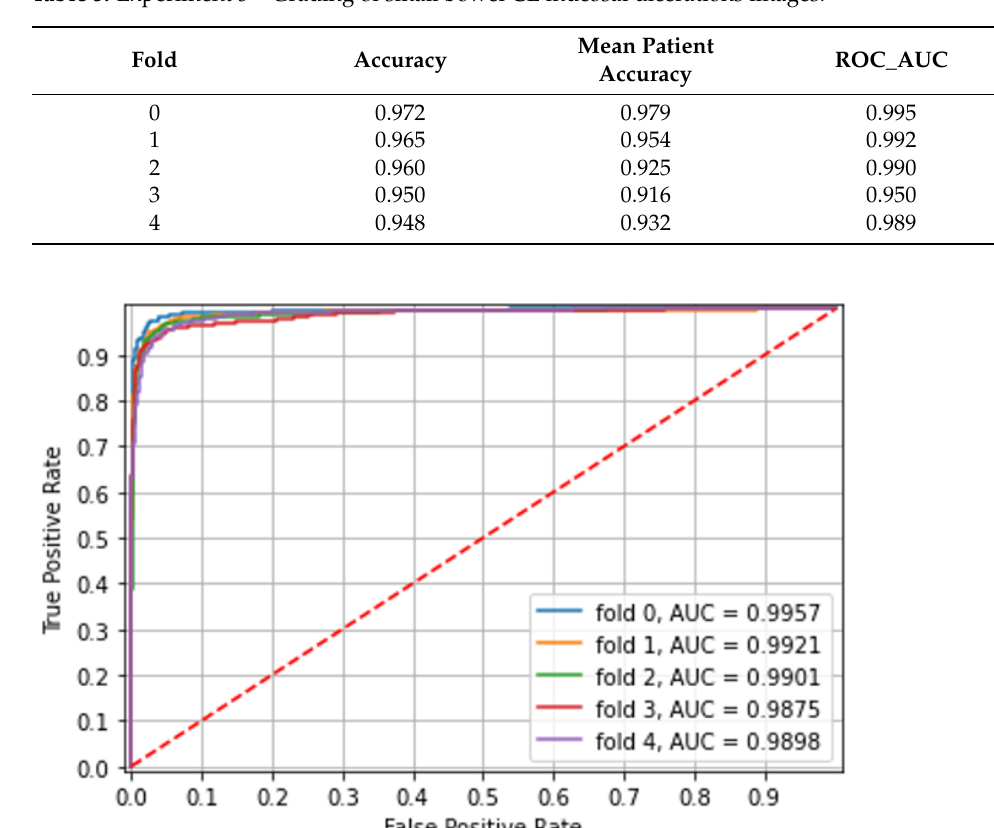
Table 5. Experiment 5—Grading of small bowel CE mucosal ulcerations images.